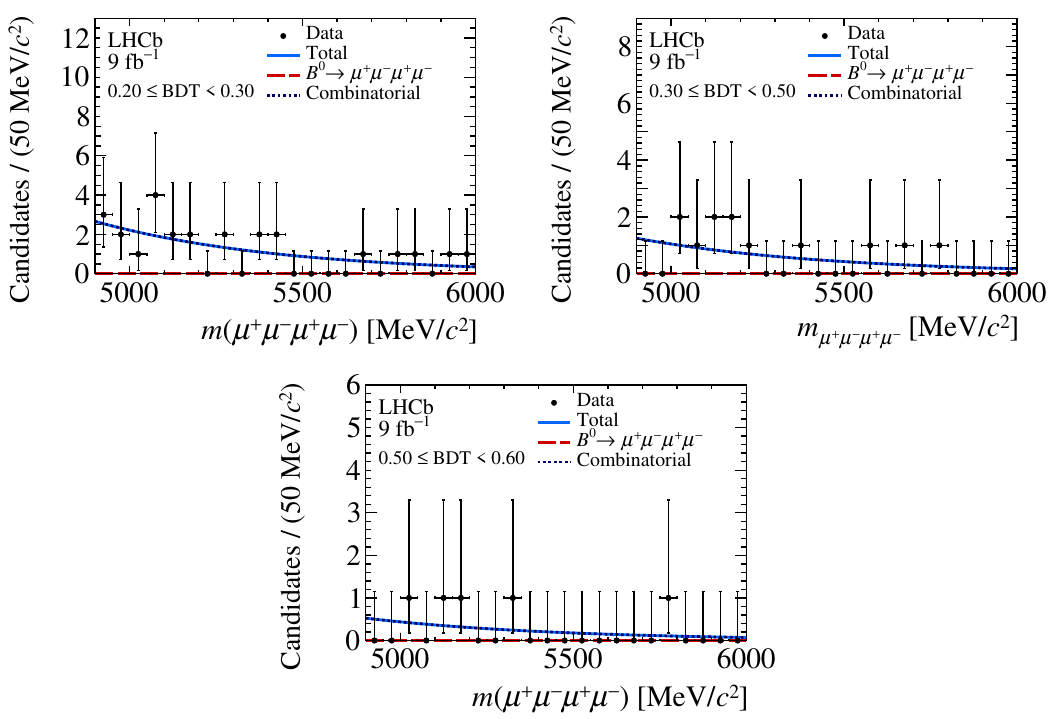
Figure 9 . Distribution of the µ + µ − µ + µ − invariant mass of candidates passing the B 0 → µ + µ − µ + µ − selection in (top left) the lowest BDT interval, (top right) the second lowest ( s ) BDT interval and (bottom) the second highest BDT interval, with the fit models used to determine the branching fraction of B 0 → µ + µ − µ + µ −